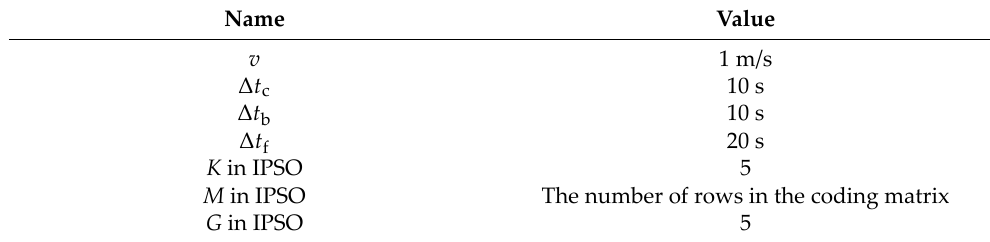
Table 3. The other simulation settings besides stations.